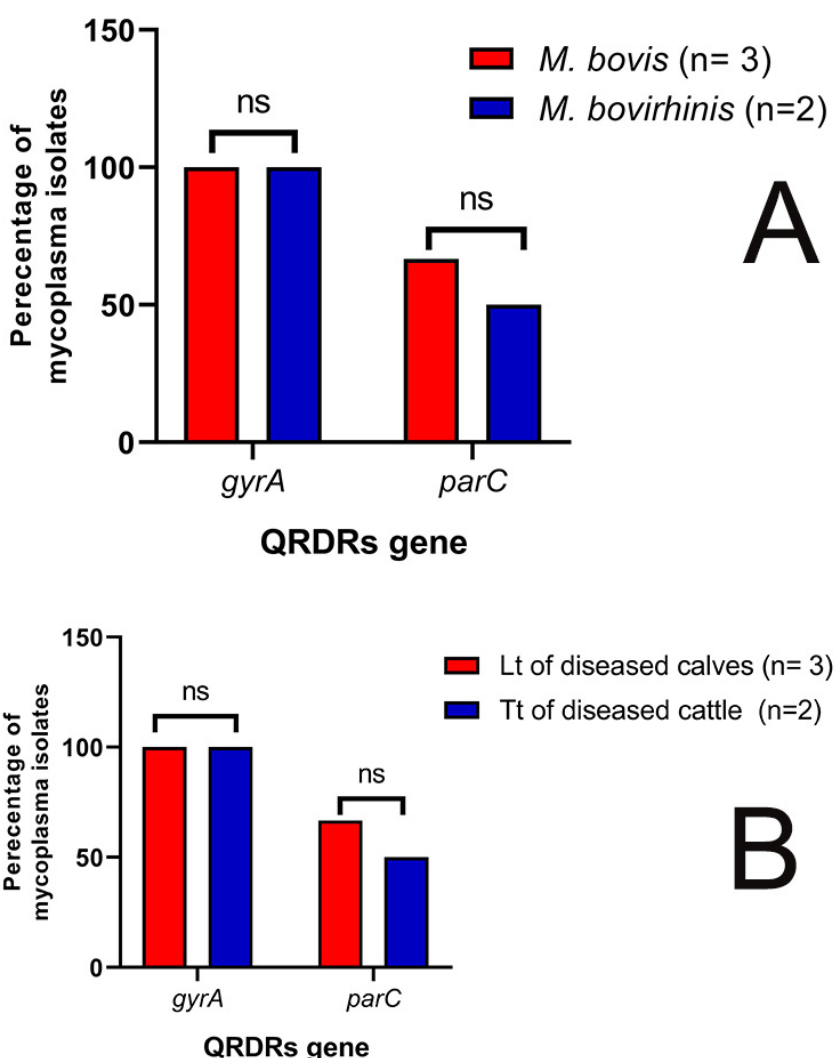
Figure 4. Prevalence of gyrA and parC genes in two bovine Mycoplasma species ( A ) and mycoplasma isolates from different samples’ sources ( B ). Lt: lung tissue, Tt: tracheal tissue, QRDRs: quinolone resistance-determining regions, ns: